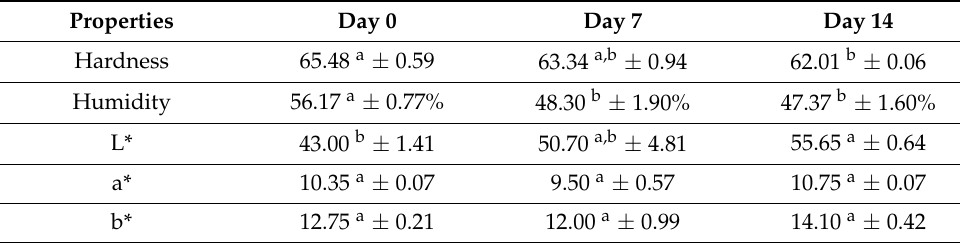
Table 8. Shelf-life